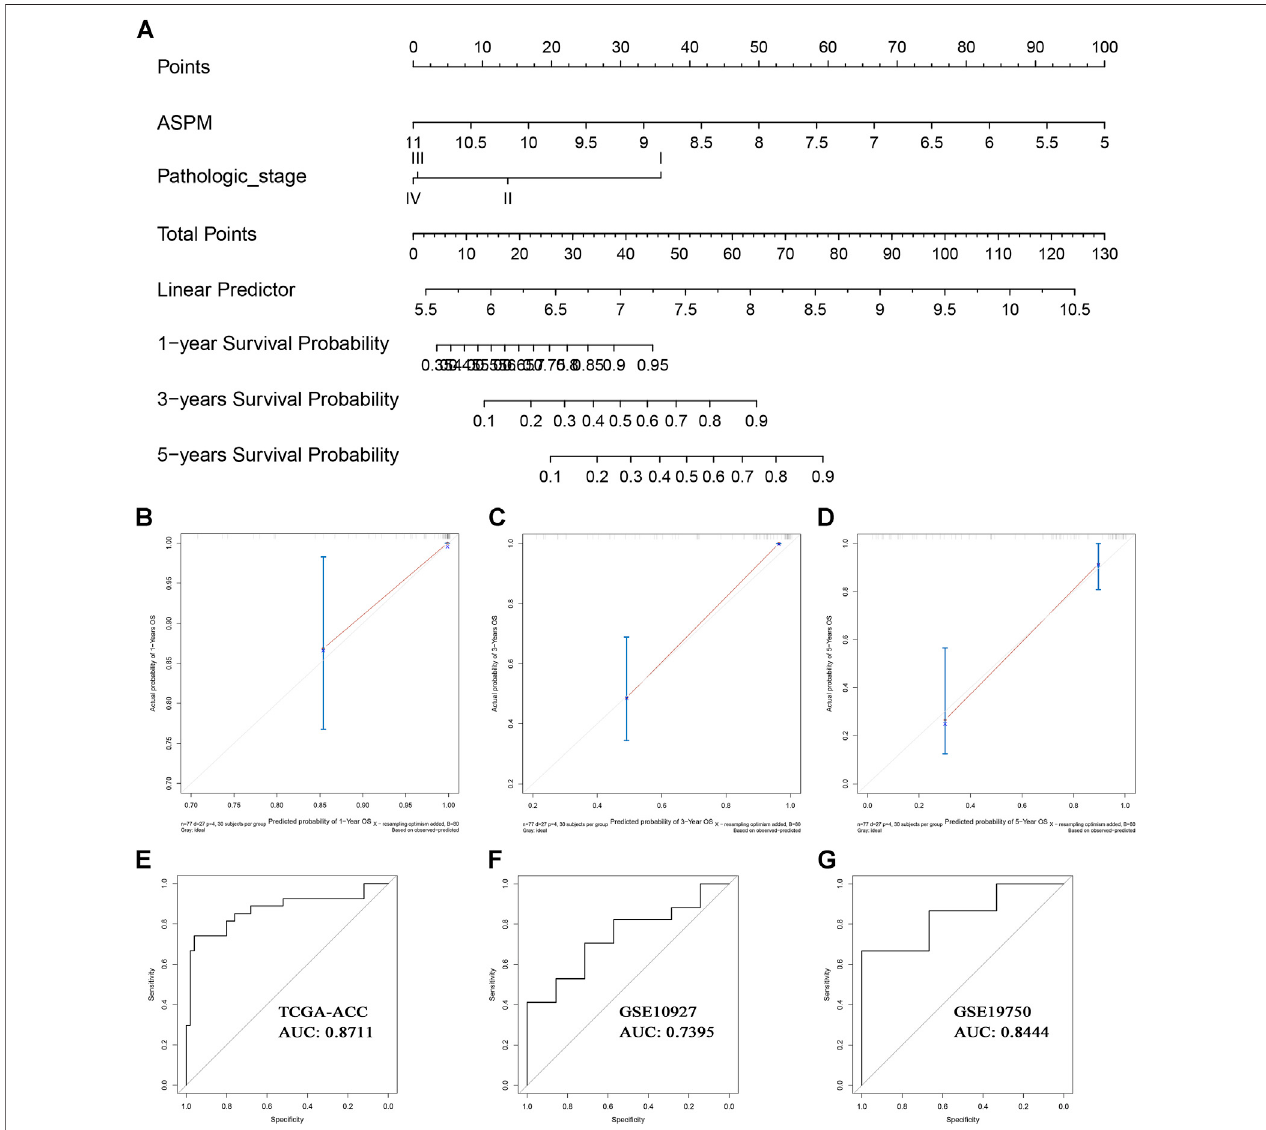
FIGURE 7 | The nomogram for predicting the proportion of ACC patients with 1-, 3-, or 5-years OS (A) . The calibration plots for predicting 1- (B) , 3- (C) , or 5- (D) year OS. Receiver operating characteristic (ROC) curves and area under the curve (AUC) statistics to evaluate the diagnostic ef fi ciency of the nomogram in TCGA-ACC data (E) , GSE10927 (F) , and GSE19750 (G)